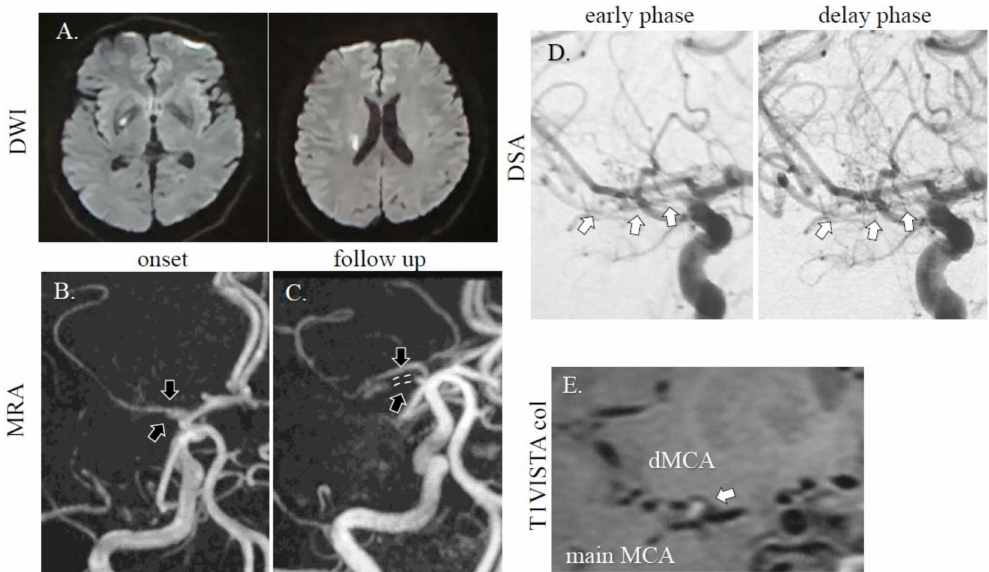
Figure 2. MRI/A and DSA images of case 2. A dotted high-intensity area was observed in the right basal ganglia area ( A ). The right MCA was faint ( B ; downwards arrow: intact MCA, upwards arrow: stenotic MCA), and there was one intact MCA and one stenotic MCA ( C ; downwards arrow: intact MCA, upwards arrow and dotted line: stenotic MCA). On DSA, a duplicated MCA was observed ( D ; arrows: stenotic MCA). On T1-VISTA colonal (col) image, intramural hematoma was found in the origin of duplicated MCA ( E ; arrow). DWI; TR, 7000 ms; TE, 120 ms. MRA (without using contrast agent); TR, 30; TE, 6.8 ms. T1-VISTA; field-of-view (FOV): 120 mm, TR: 400 ms, TE: 10ms, volume-of-interest (VOI) size: 1 × 1 × 1 mm, 100